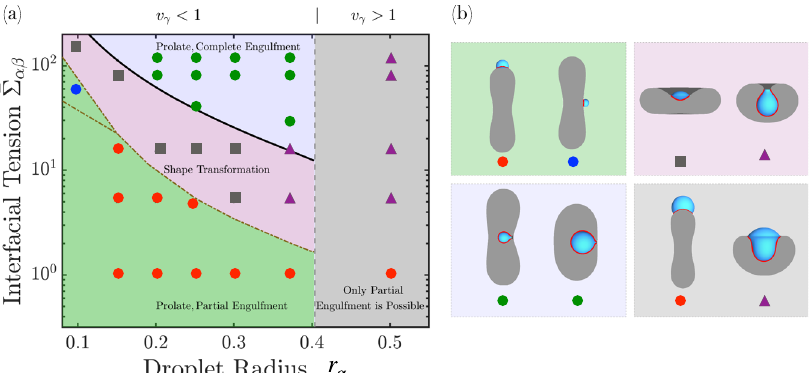
Fig. 3 Morphology diagram for nanodroplet endocytosis. The volume-to-area ratio of the vesicle is constant v = 0.7 which implies that in the absence of the nanodroplet, the vesicle attains a prolate shape as the minimum energy shape 21 . The dash-dotted brown line represents the transition line where two shapes with different morphologies have the same free energy. Complete engulfment is only possible when γ phase volume-to-area ratio of the γ phase satis fi es v γ < 1 provided that the interfacial tension is large enough. The green region corresponds to the partial engulfment region where the nanodroplet does not change the prolate morphology of the vesicle. In the pink region, shape transformations from prolates to oblates and stomatocytes are observed where the nanodroplet is partially engulfed. The solid black line indicates the critical interfacial tension when the interfacial energy equals the bending rigidity of spherical out-bud, Σ αβ = 8 πκ / A αβ , where A αβ is the area of αβ interface. The complete engulfment and the limit shapes are only possible in the light blue region where the interfacial tension is larger than the critical value. The vertical dashed gray line corresponds to v γ = 1 and for larger values of r α only partial engulfment is possible, (gray region). For the morphology diagram in ( a ) the background color and the symbols correspond to the typical vesicle-droplet morphology in ( b ). The vesicle radius is R ve = 1 μ m, the bending rigidity of the vesicle is κ = 20 k B T and the spontaneous curvature is